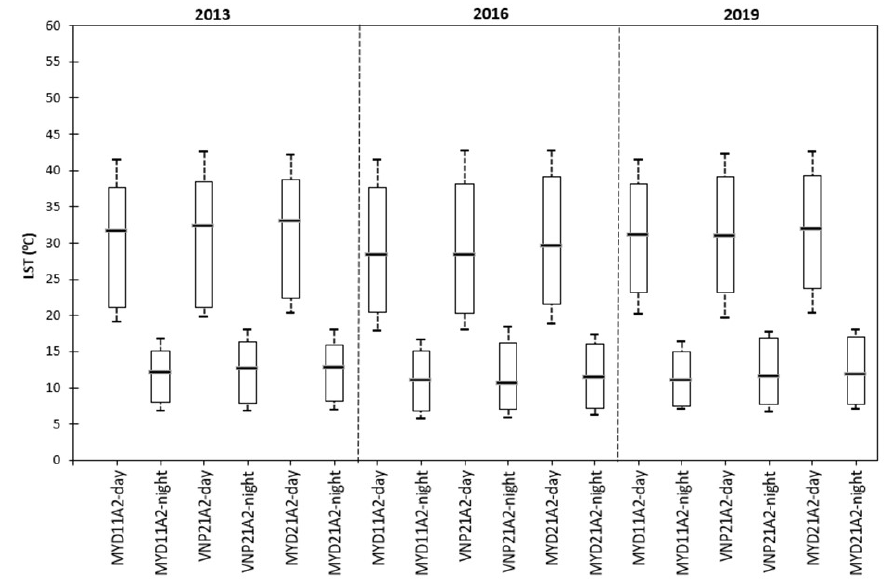
Figure 7. Boxplot showing the yearly diurnal ranges for the three LST products for Perth. This consists of 25th percentile (1st quartile), median (2nd quartile), 75th percentile (3rd quartile), and min (10th percentile)/max (90th percentile) values.